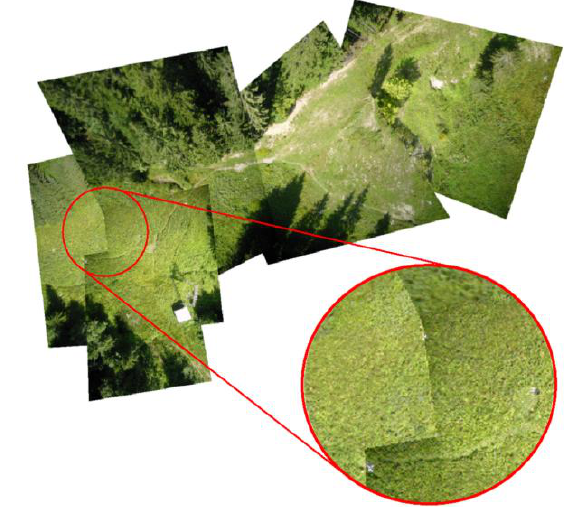
Figure 3. Mosaic of the Heumoes landslide with clearly visible